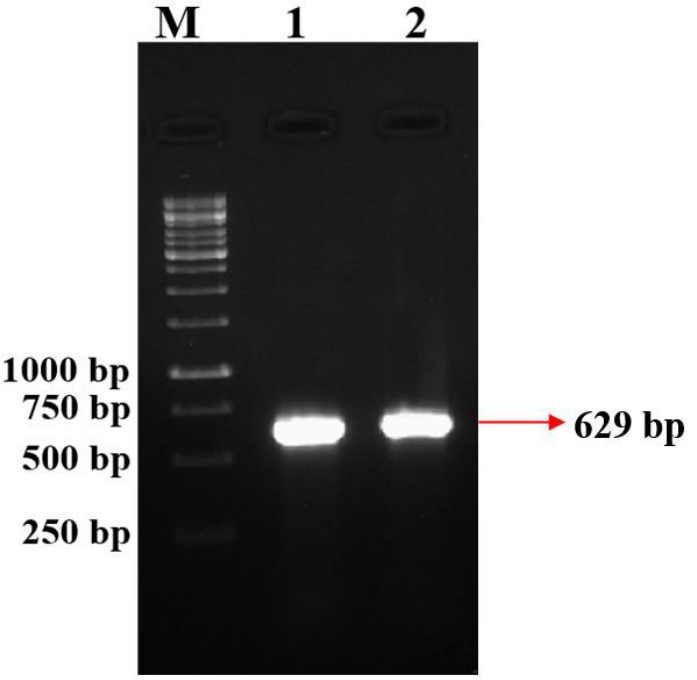
Figure 3. Detection of DAPG encoding gene from P. fluorescens VSMKU3054. M-Marker (1 kb), 1 — CHAO, 2 — P. fluorescens. 1—CHAO, 2— P. fluorescens